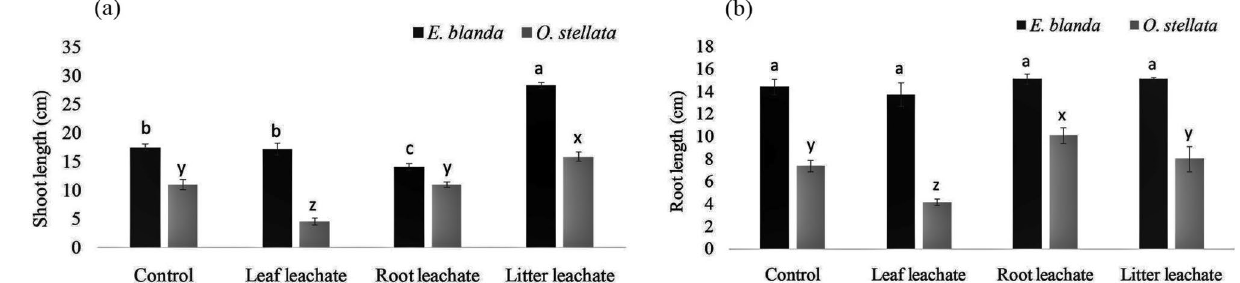
Figure 1. Effect of A. adenophora leachates on ( a ) shoot length and, ( b ) root length of native E. blanda and O. stellata. Different letters above the error bar indicate significant differences among the treatments (‘a’, ‘b’, and